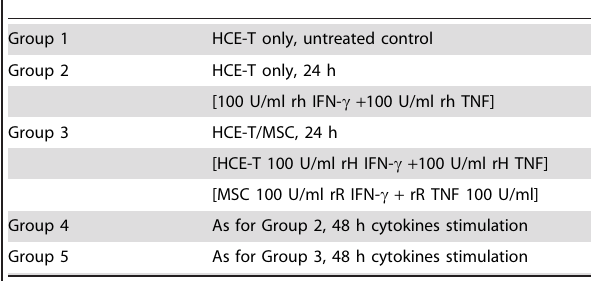
Table 1. Cytokine Treatment Groups.